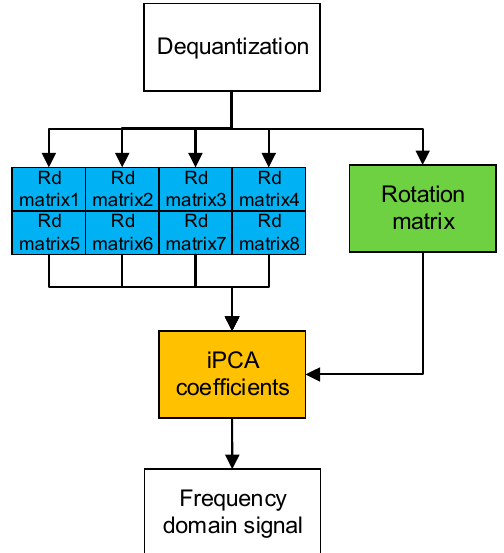
Figure 8. Multi-frame in decoder. (iPCA, inverse Principle Component Analysis; Rd, reduced- dimensional).